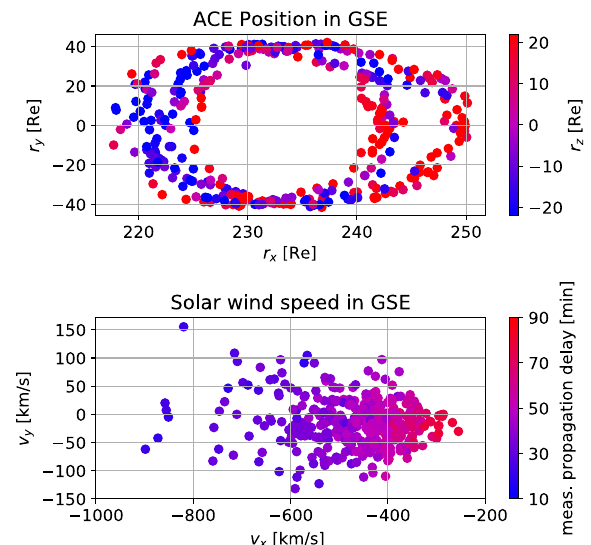
Fig. 2. Overview of the database for the calculation of the solar wind propagation delay, top panel shows the ACE position in X , Y , Z , bottom panel shows the measured solar wind propagation delay and the solar wind speed in X , Y , all units are given in GSE coordinates, except the propagation delay (min).